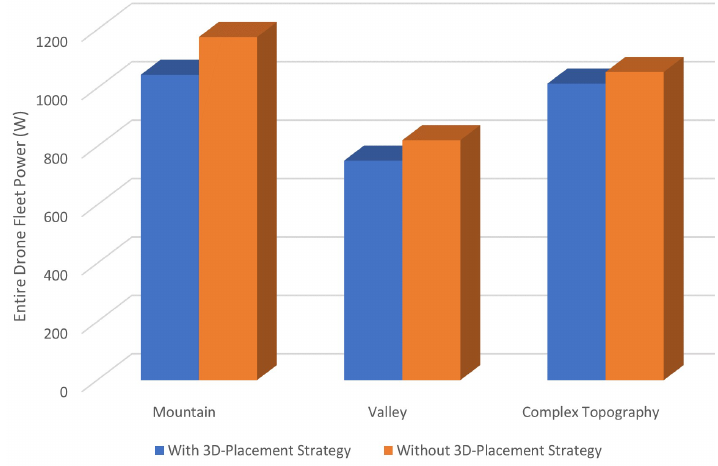
Figure 8. The drone positioning algorithm